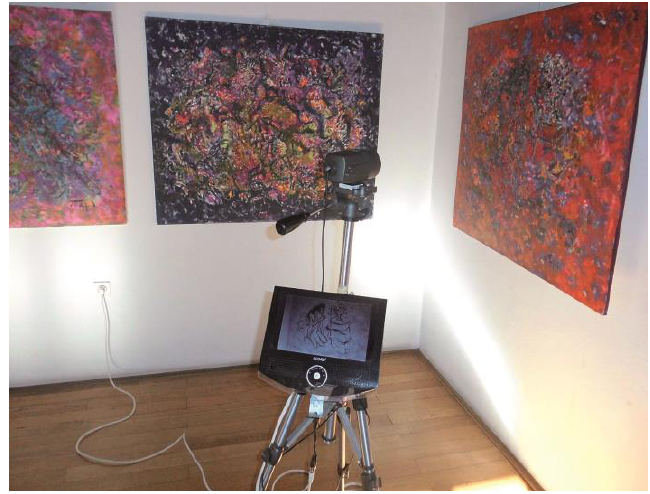
Figure 8. Sveti Ivan Zelina Gallery, acrylic on canvas by the painter Nada Žiljak. View of the exhibition in the V spectrum.